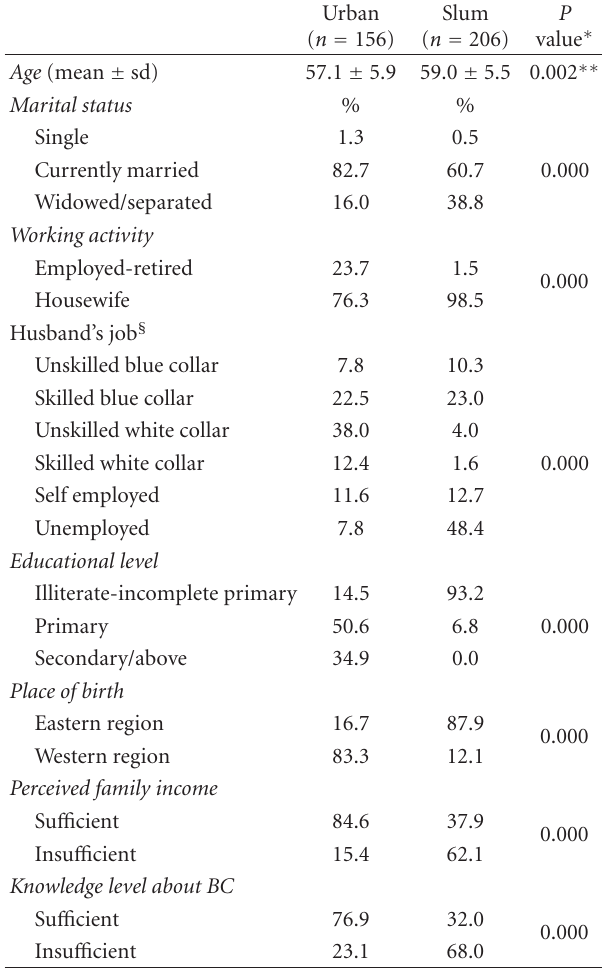
Table 1: Sociodemographic characteristics and knowledge levels about BC of women according to